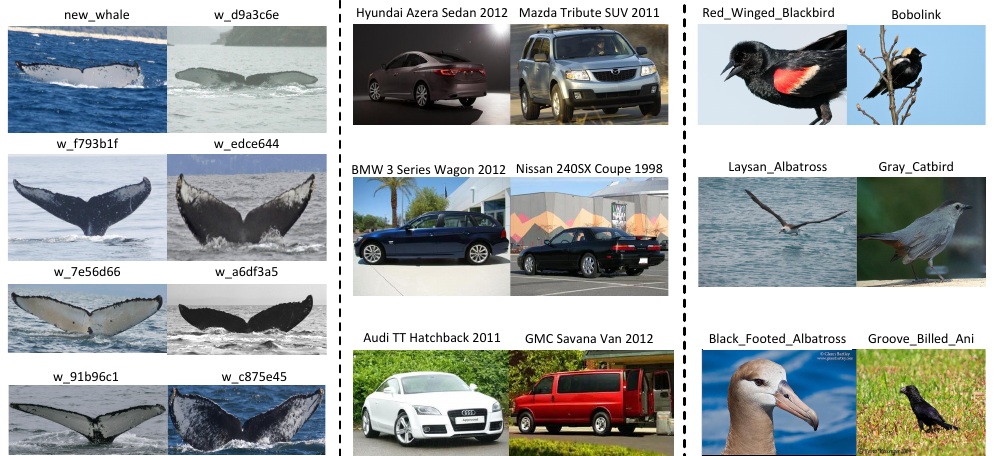
Figure 6. We randomly selected test data from the competition and the other two widely-used datasets, from which it can be seen that our method provides the correct